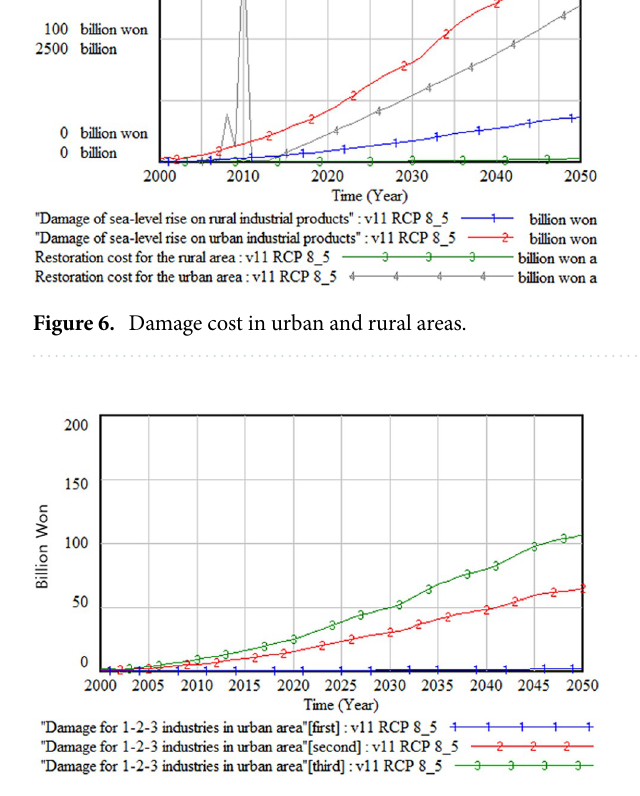
Figure 7. Industry damage in the urban area.